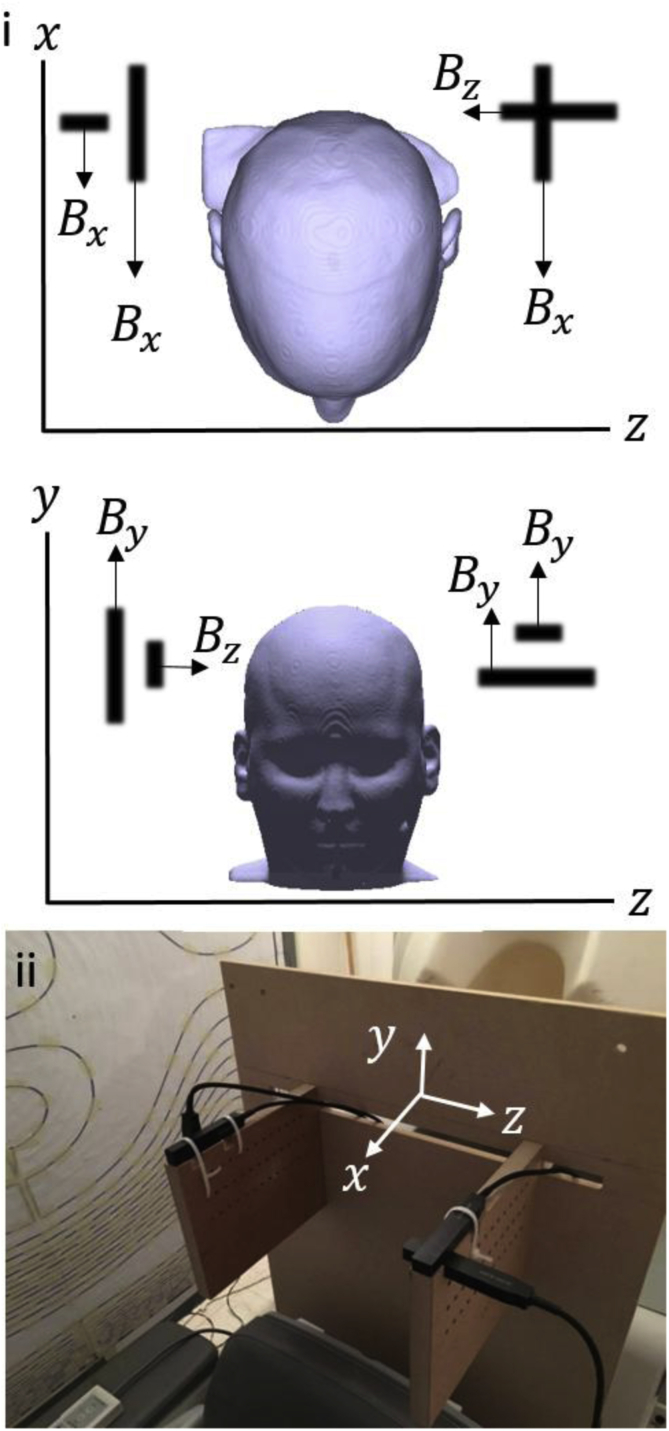
i) The positions and orientations of the four OPMs used for reference measurements. The OPMs are positioned such that a measurement of each field component can be made at two different z−positions to provide a measure of the field gradients. ii) The reference array as set up for an experiment.